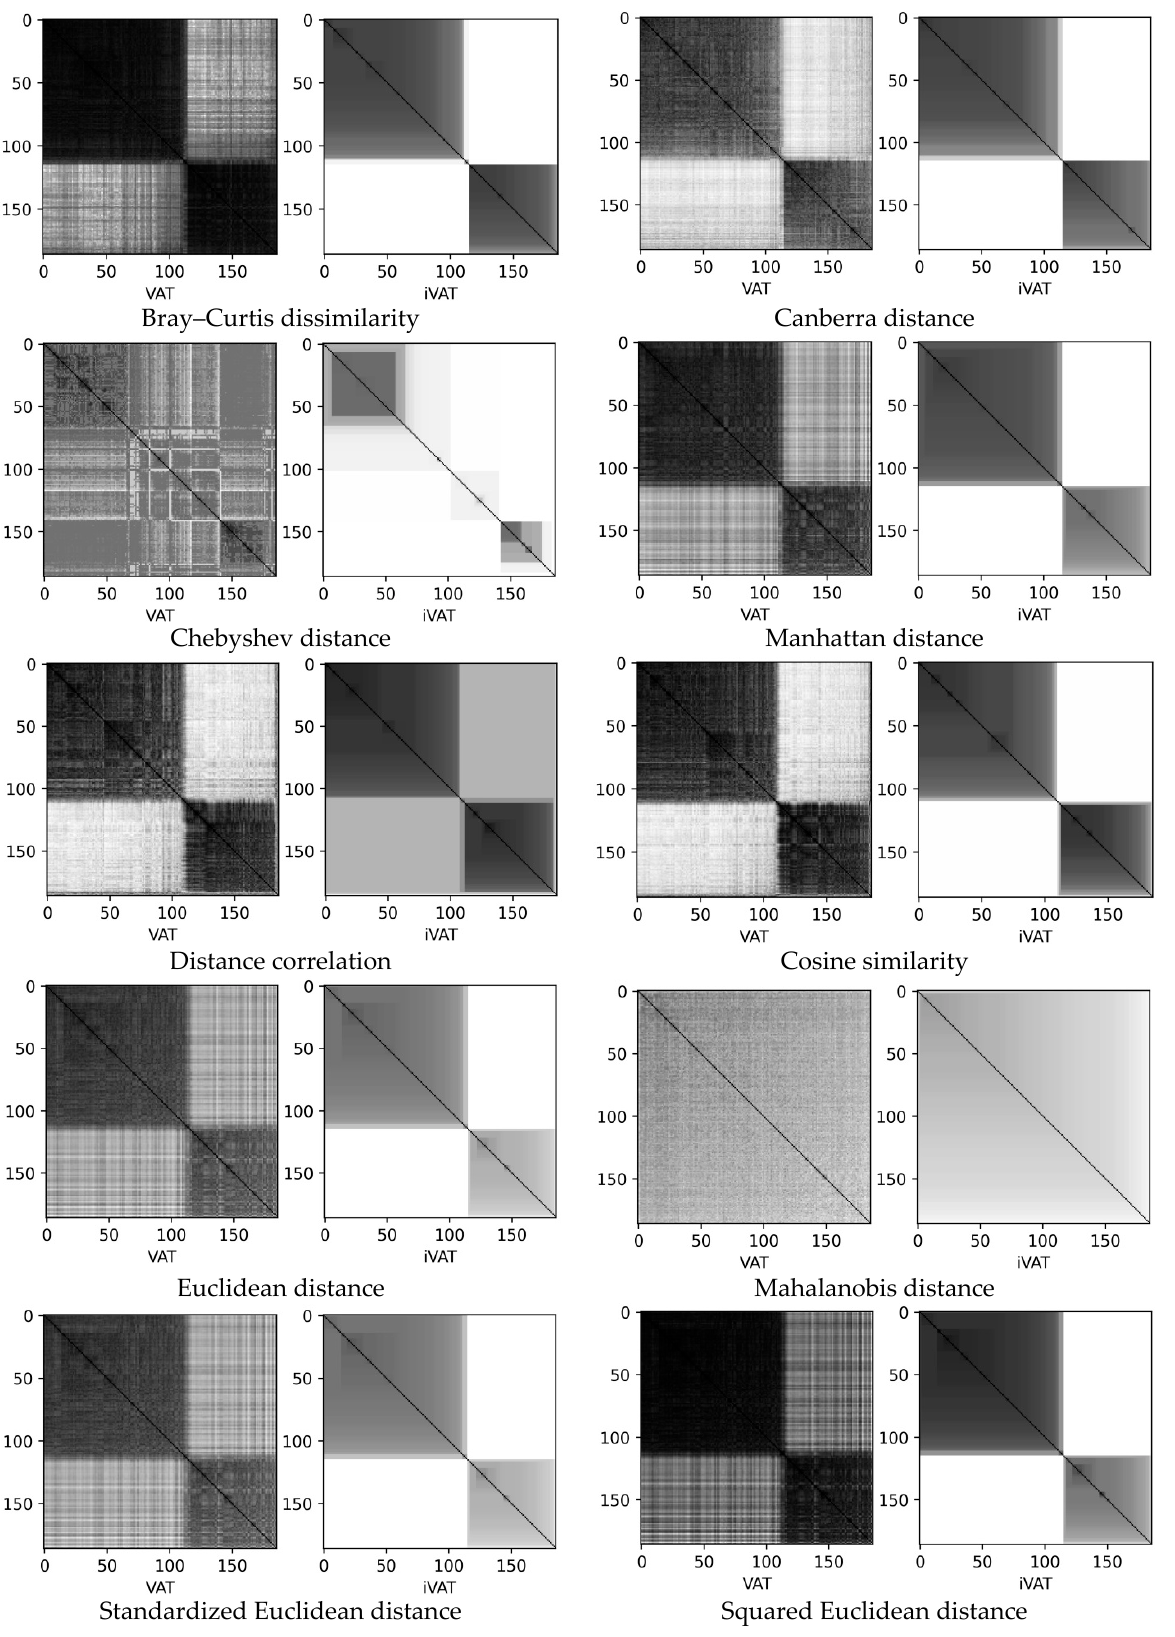
Figure A7. Microchips 1526IE10_002, two-batch mixed lot. Cluster heat map.